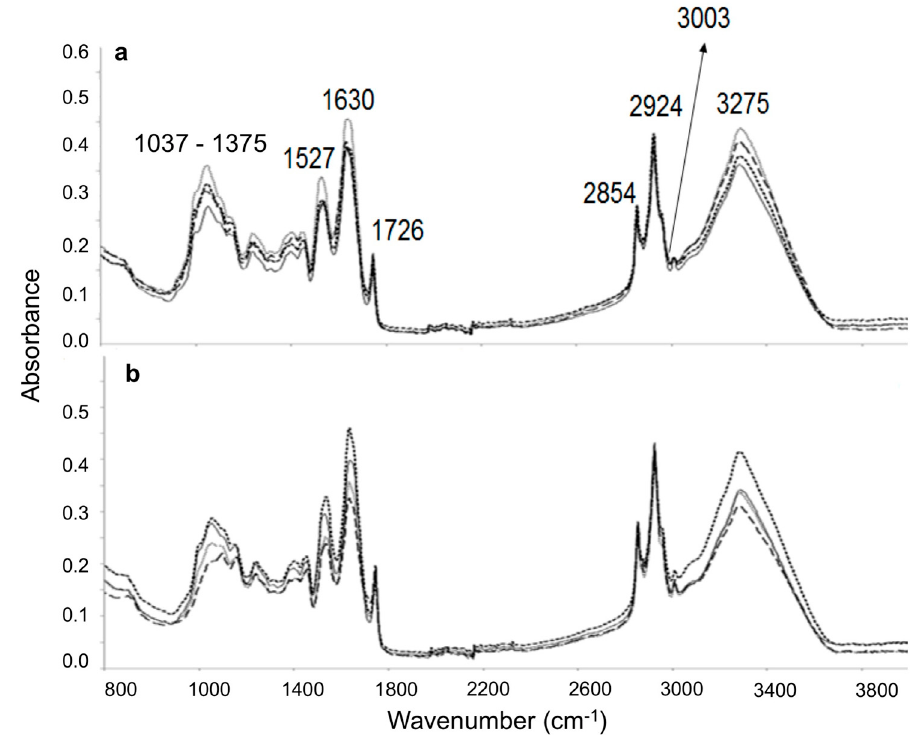
Figure 4. ATR-FTIR spectra of roasted ( a ) and fried ( b ) sunflower seed samples at zero ( ), three ( ), five ( ), and 10 ( ) days of oxidative treatment at 100 °C.